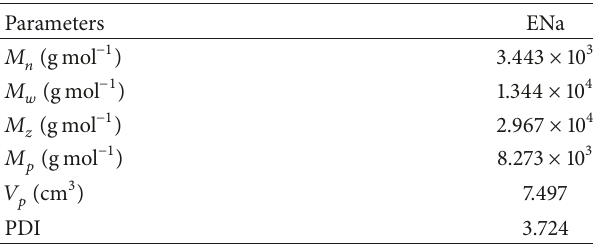
Table 3: GPC parameters of